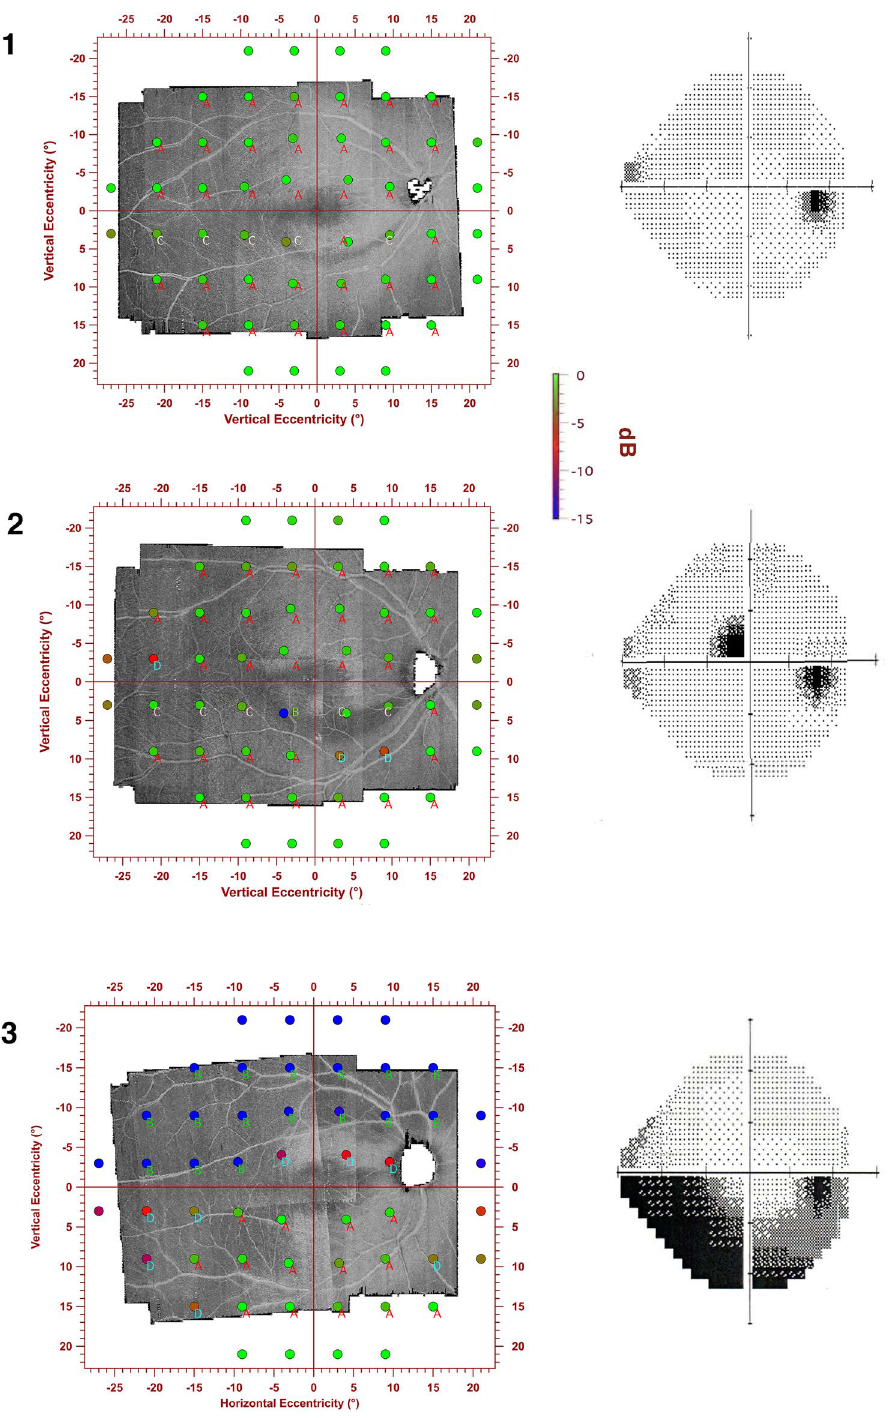
Figure 4. Three eyes from our study, all right eyes. The left column shows perimetric locations overlayed on the en face OCT custom slab image. The perimetric locations are color-coded to indicate the depth of perimetric defect and have been inverted so that the correspondence of perimetric and RNFL bundle reflectance loss can be appreciated. The right column shows the greyscale from the Humphrey Field Analyzer printout. Case 1 , a 64-year-old with Mean Deviation, MD of − 0.47 dB. Case 2 , a 70-year-old with MD of − 2.66 dB; Case 3 , a 54-year-old patient with MD of − 13.64 dB. Some examples of locations with visible RNFL bundle loss and normal perimetric sensitivity (yellow arrows) and locations with abnormal sensitivity and normal RNFL bundle reflectance (cyan arrows) are shown. Letters next to each perimetric location represent one of four categories; (A) is for normal perimetric locations that fell within normal reflectance regions of the RNFL bundles. (B) defective perimetric locations that fell within low reflectance regions of the RNFL bundles. (C) normal perimetric locations that fell within low reflectance regions of the RNFL bundles. (D) defective perimetric locations that fell within normal regions of the RNFL